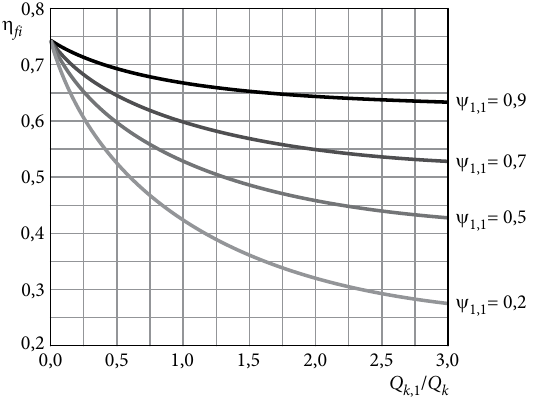
shift according to Q fi